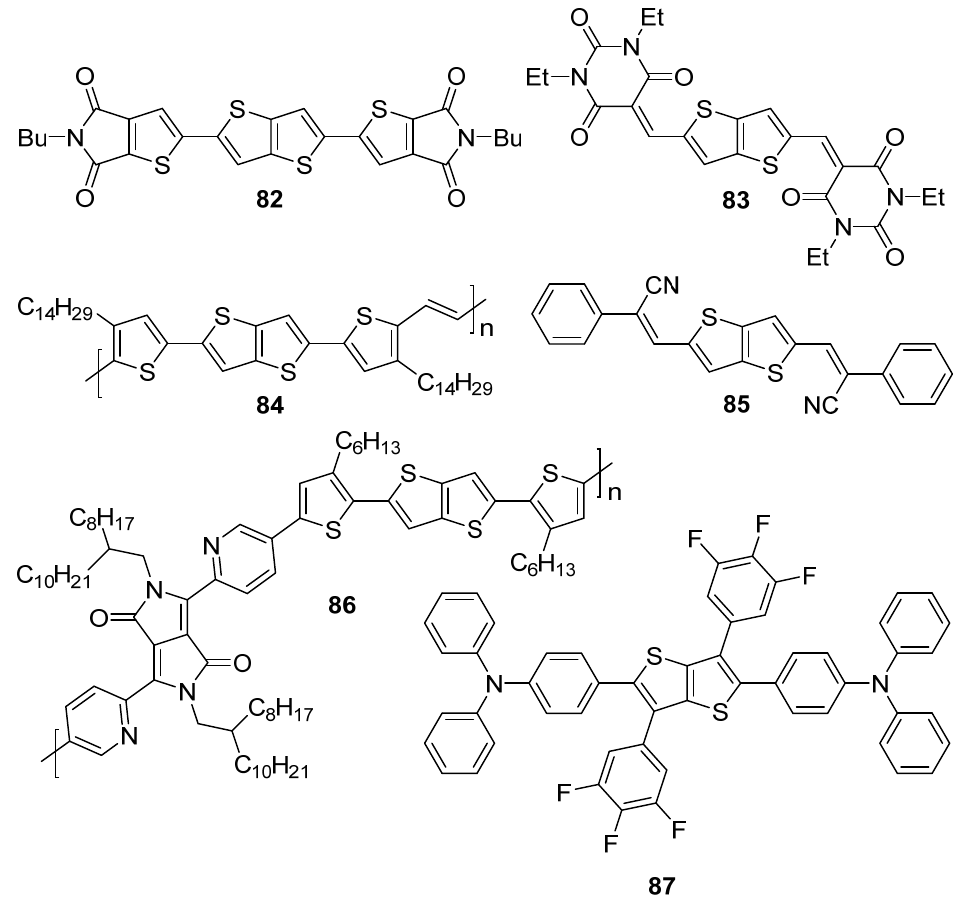
Figure 12. Thieno[3,2- b ]thiophene-derived semiconductors 82 – 87 .